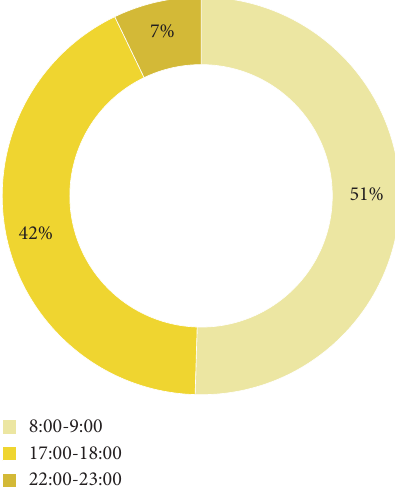
Figure 5: Distribution of illegal parking in different periods on the second day.